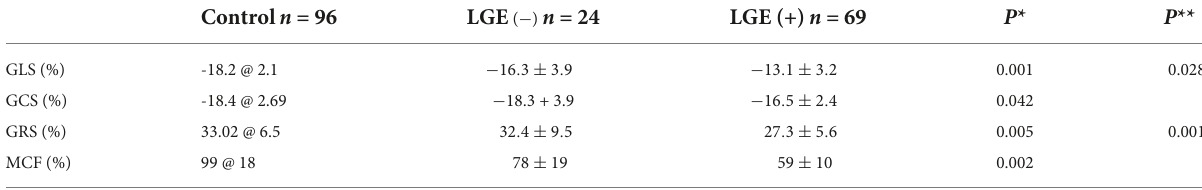
were manually drawn on the delayed reinforcement left ventricular two-chamber short-axis images using the LGE quantification module in CVI software. LGE myocardial volume was quantified by five standard deviations (SD) of the distal normal myocardial signal above the same level (11), and the software calculation automatically obtained LGE myocardial volume